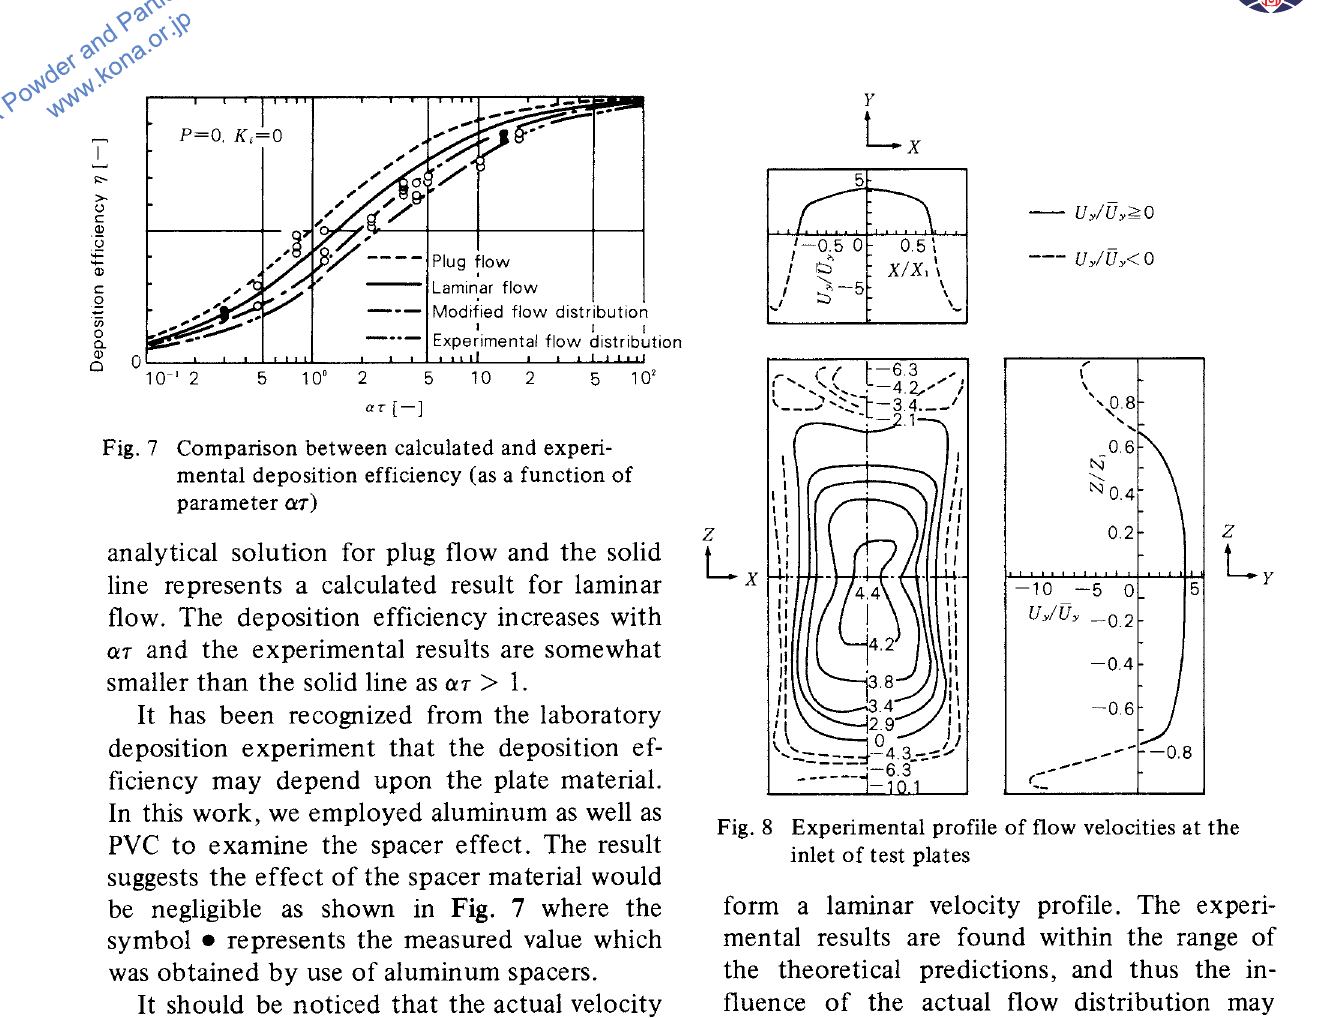
Fig. 8 Experimental profile of flow velocities at the inlet of test